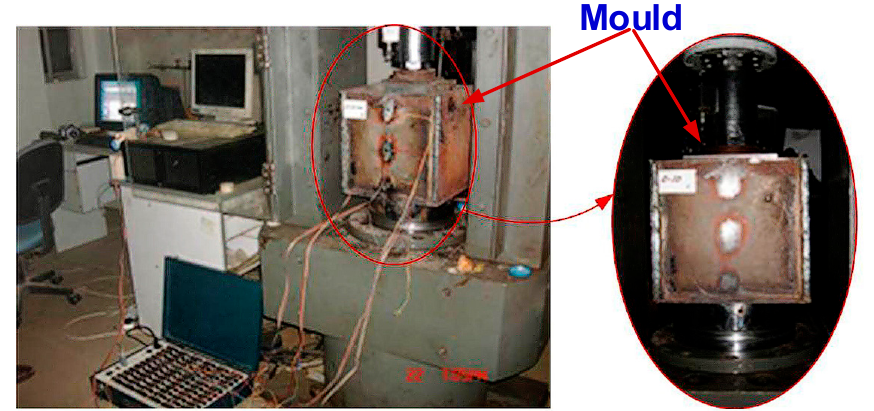
Figure 8. Device and molds used in loading test of rubble.